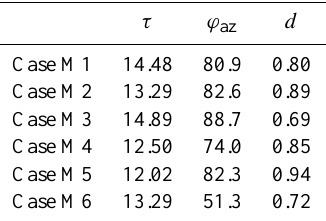
Results of phase and group velocity analysis: the number of wave packets n satisfying condition (9), and their Table 6. Results of Stokes parameters analysis: intrinsic period, mean ± standard deviation of their intrinsic period τ (h), vertical wavelength λ z (km), and horizontal wave length λ h (km).